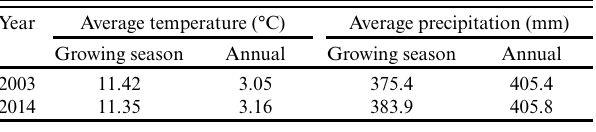
Table 4 . Average temperature and precipitation during the growing season and for the year in Guinan County (http://data. cma.cn/).